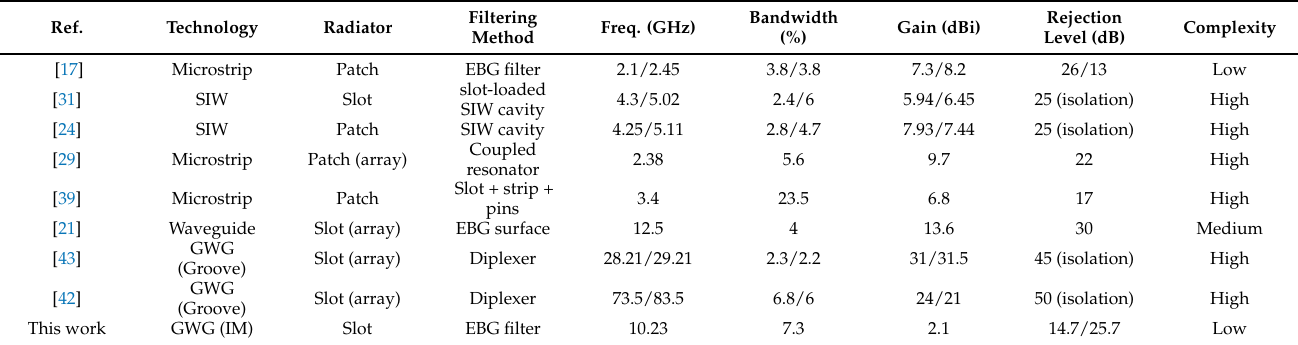
Table 5. Performance comparison with other reported filtering